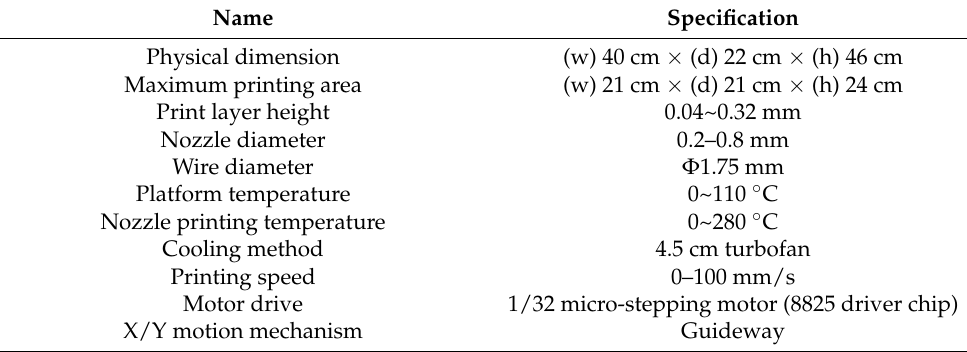
Table 1. The specifications of the 3D printer.